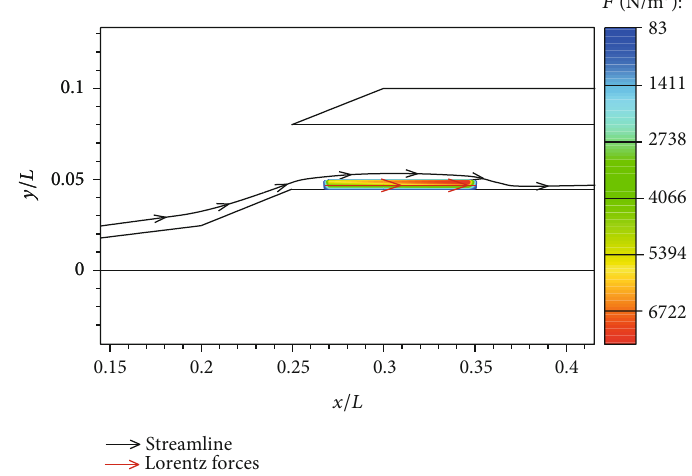
Figure 19: Local Lorentz force and streamline distributions of MHD separation fl ow control system ( B = 3 : 0T ).